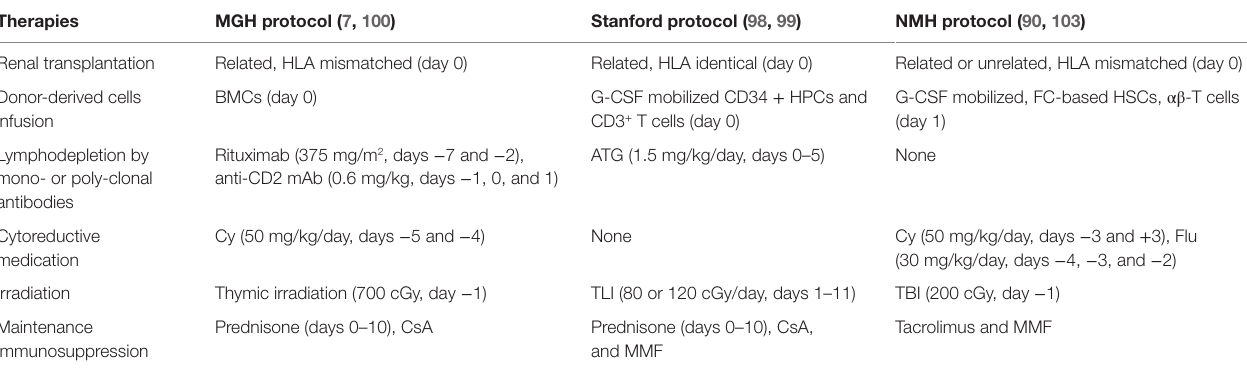
TABLe 2 | Comparison of different non-myeloablative conditioning protocols for tolerance induction in renal transplantation.